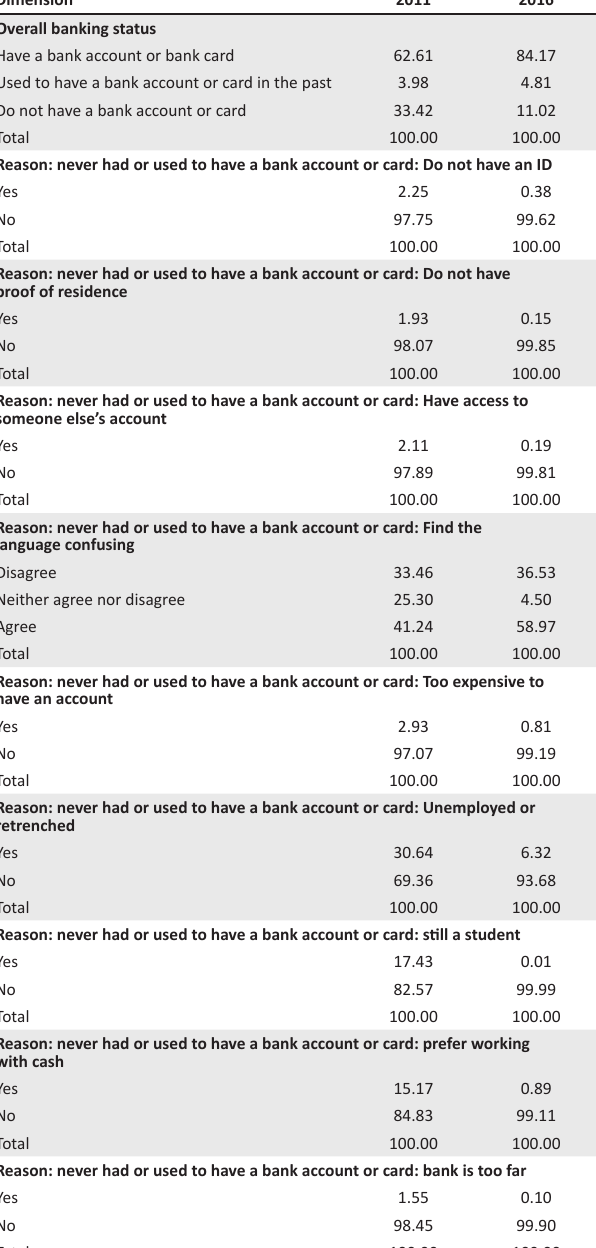
TABLE 2-A1: Description of data on the usage dimension of financial inclusion ( % ).